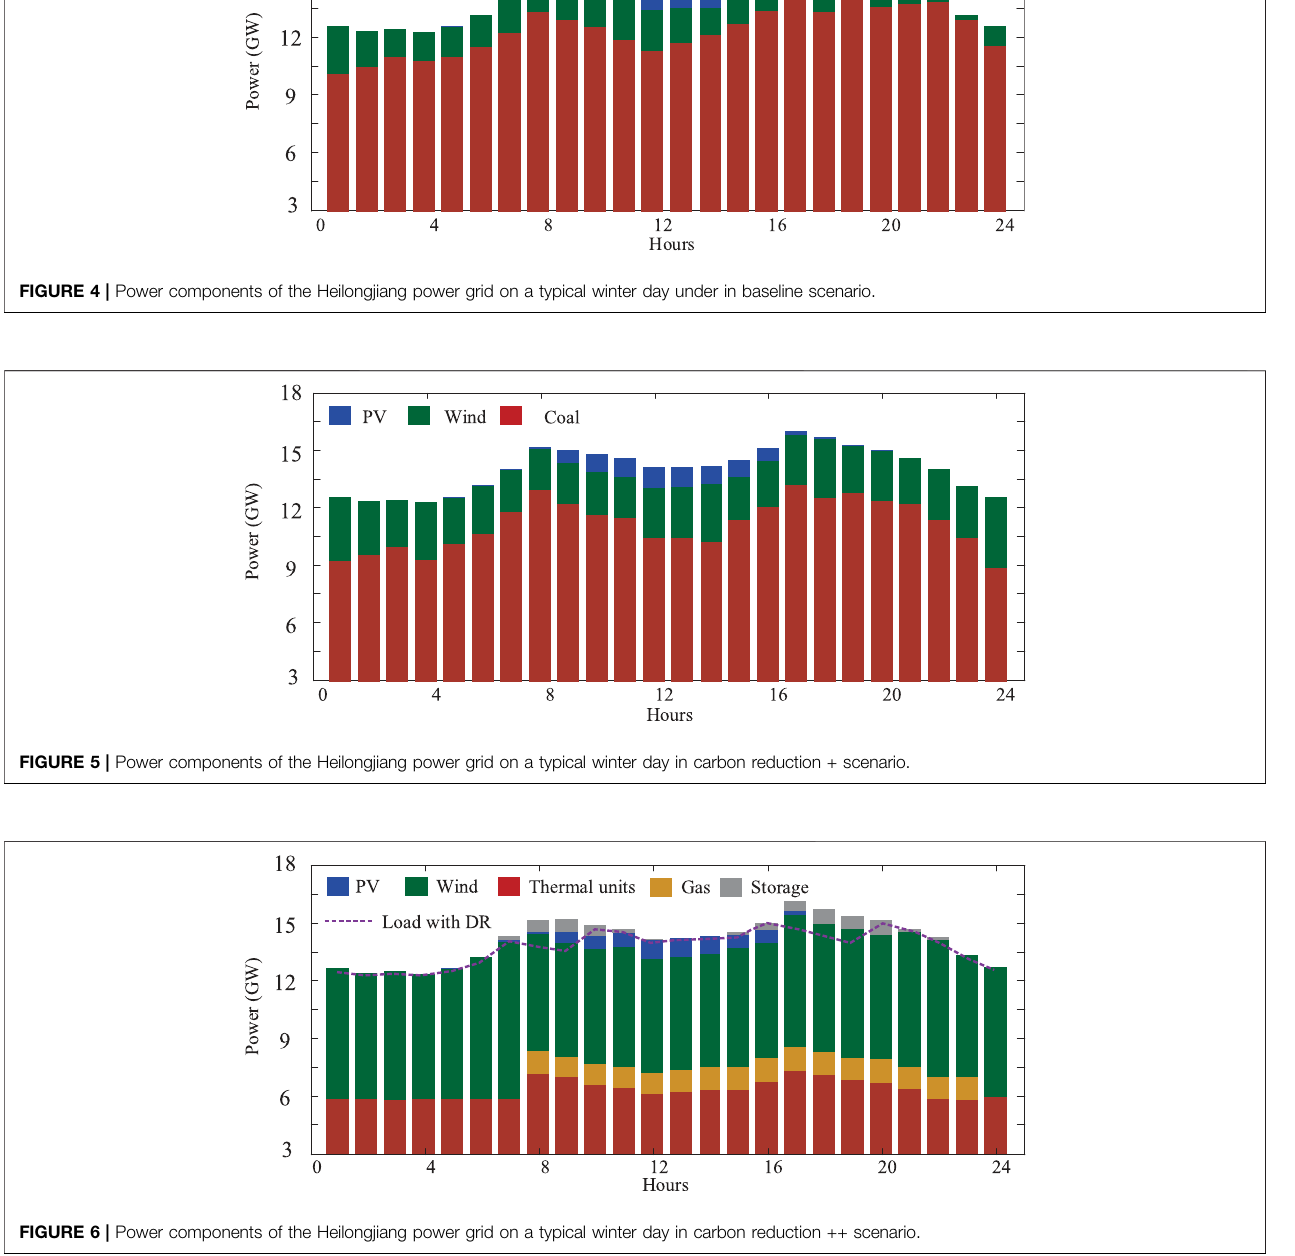
Frontiers in Energy Research |